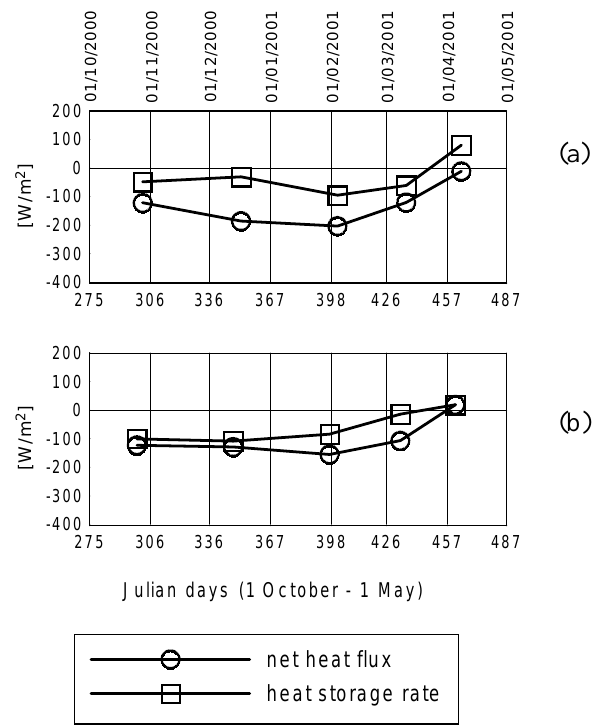
Fig. 6. Time averaged net heat flux at the air-sea interface and the heat storage rate in the upper layer for the period between 27 September 2000 and 15 April 2001 at a monthly time scale: in the southern Adriatic (a) and in the NW Ionian (b) . The heat stor- age rate refers to the water column between 5 and 450m. The time scale refers to the upper integral limit t 2 from Eq. (3) in the